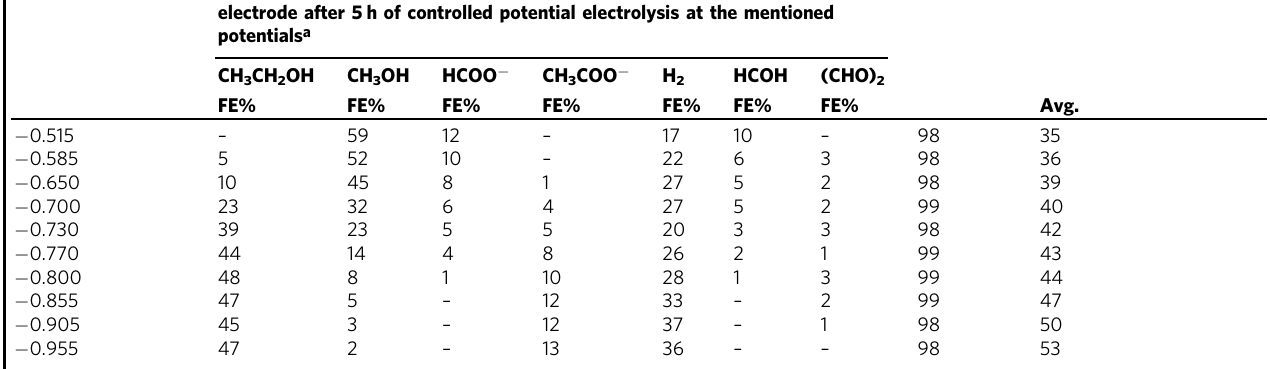
Table 1 Average Faradaic ef fi ciency for each product detected on the Co-corrole-carbon paper electrode Potential V vs. RHE